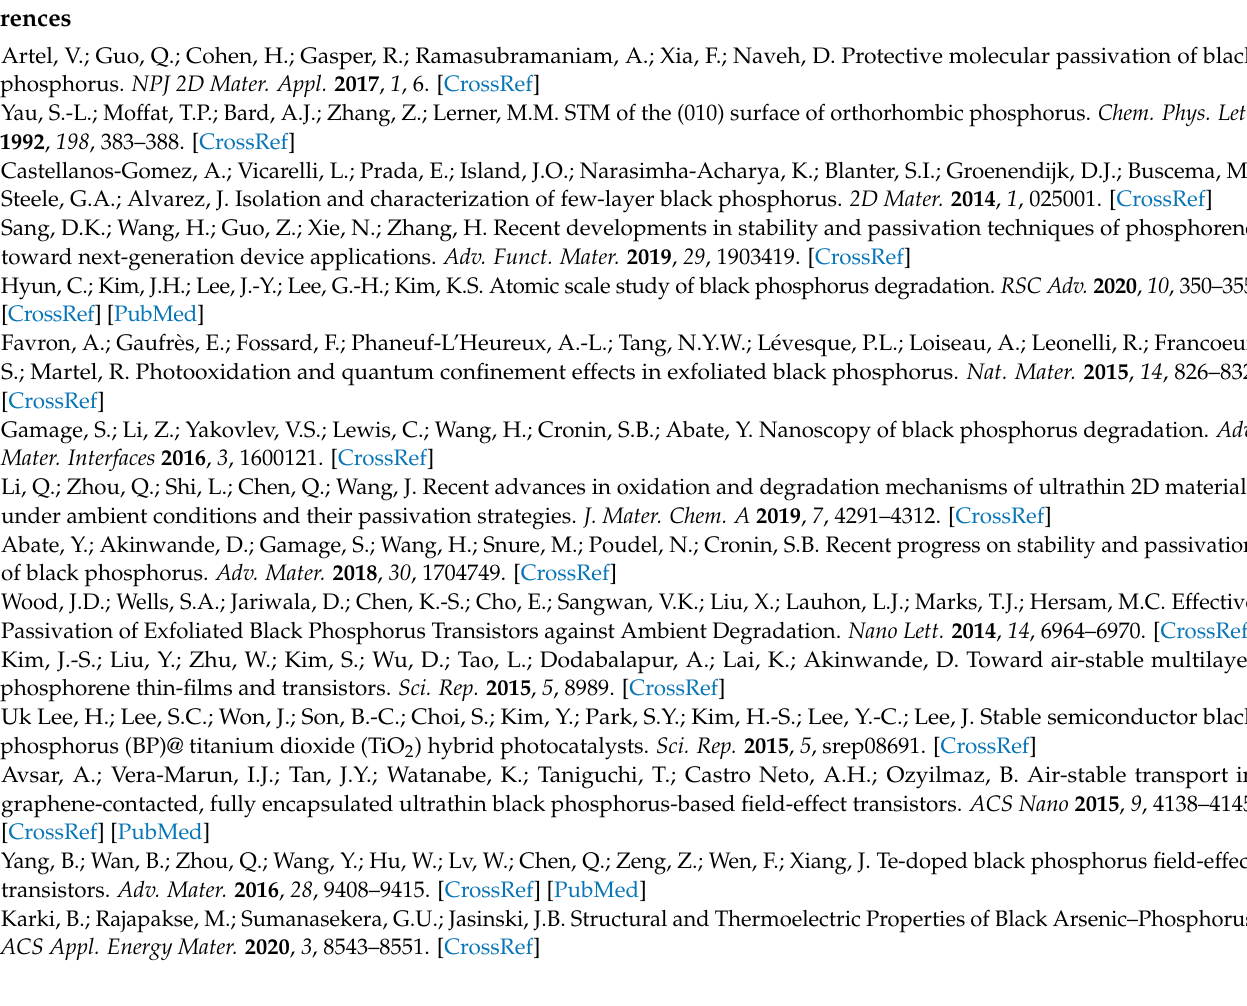
Figure S2: Degradation of the peak intensities of P–P Raman vibration modes. (a) A 1 g (b) B 2g (c) A 2 g ; Figure S3: Peak positions for P–P Raman vibration modes. (a) A 1 g (b) B 2g (c) A 2 g ; Table S1: Decay function parameters for Raman spectra; Table S2: Growth function parameters for normalized thermoelectric power (TEP); Table S3: Decay function parameters for normalized resistance; Figure S4: Response of the electrical transport properties of BP and As 0.4 P 0.6 to heating and cooling. (a) TEP and (b)